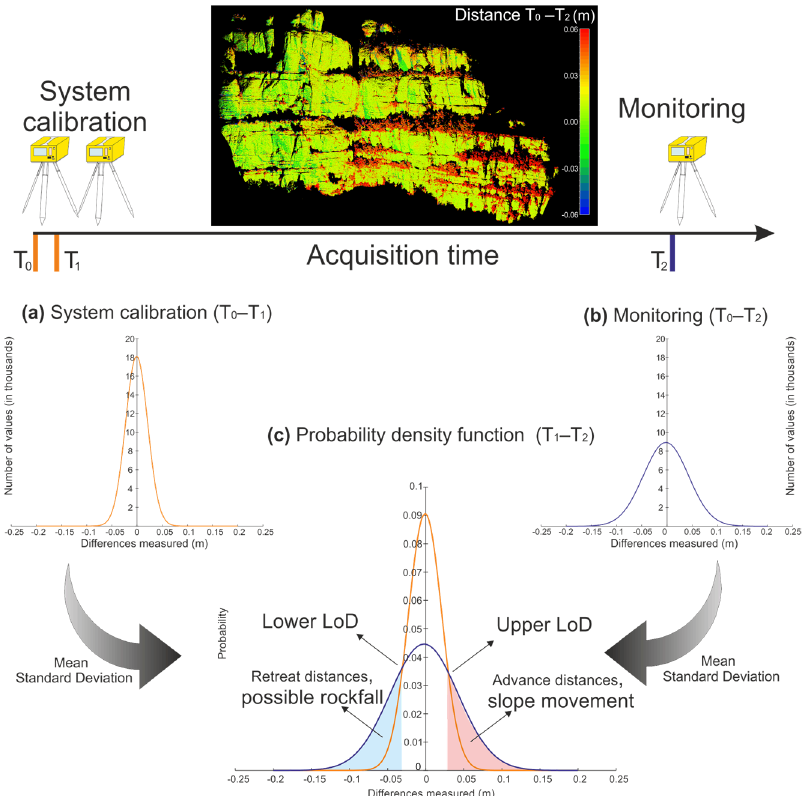
Figure 3. Depiction of the method for calculating the LoD and interpretation of the result. ( a ) Distribution of the differences between the initial data acquisition and the repetition in the minimum time interval (T 0 –T 1 ), with the aim of repeating the same conditions in order to calculate the systematic error. ( b ) Distribution of the feature differences calculated during the monitoring for a certain period of time (T 0 –T 2 ). ( c ) Superposition of distributions to calculate the LoD (intersection between orange and blue lines). The areas in red mark the values assigned to advanced processes, and those in blue assigned to decrease due to a loss of